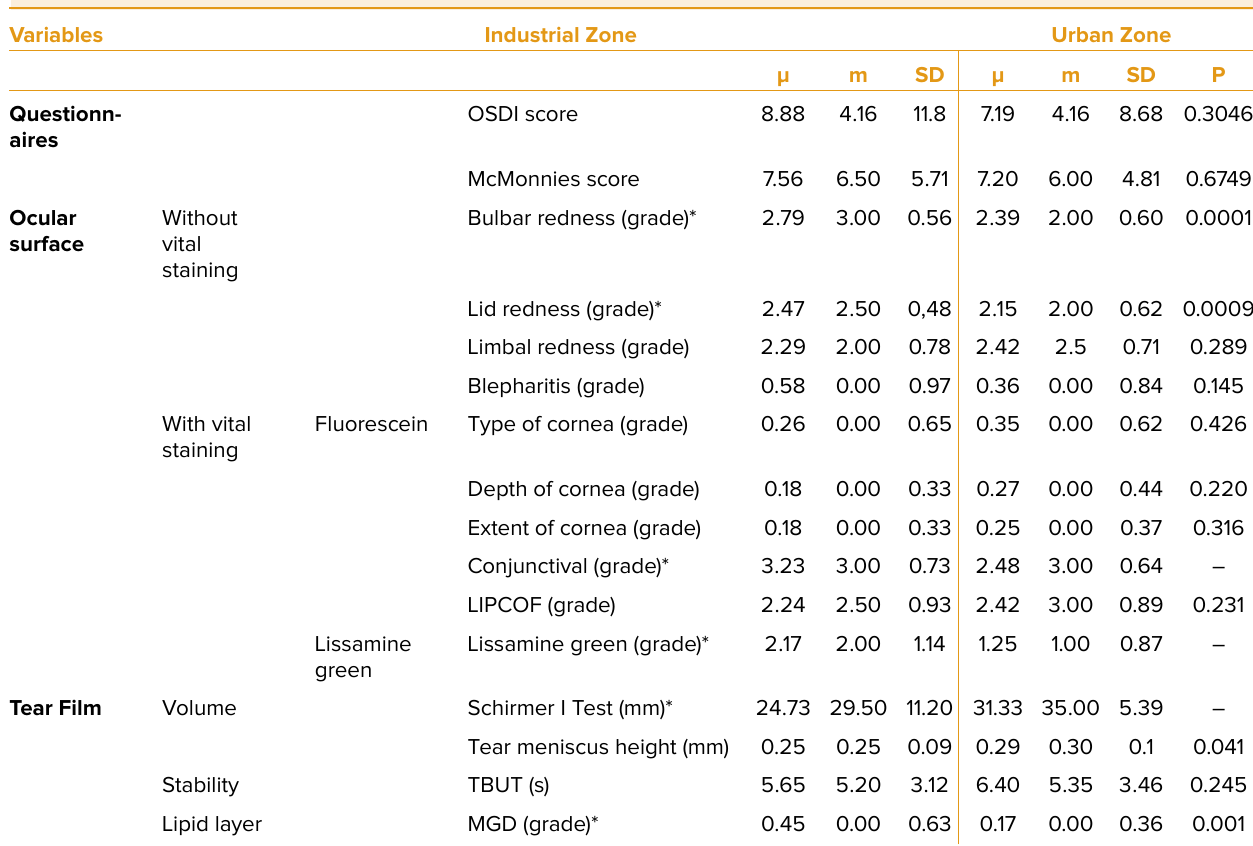
Table 2. Outer segment characteristics. The values of the number of the sample ( n ) are detailed; the mean (μ); the median ( m ); and the standard deviation (SD) for each study area are provided. The P -value is also reported according to the Student’s T -test. The variables that presented significant differences between populations (*) are indicated in bold